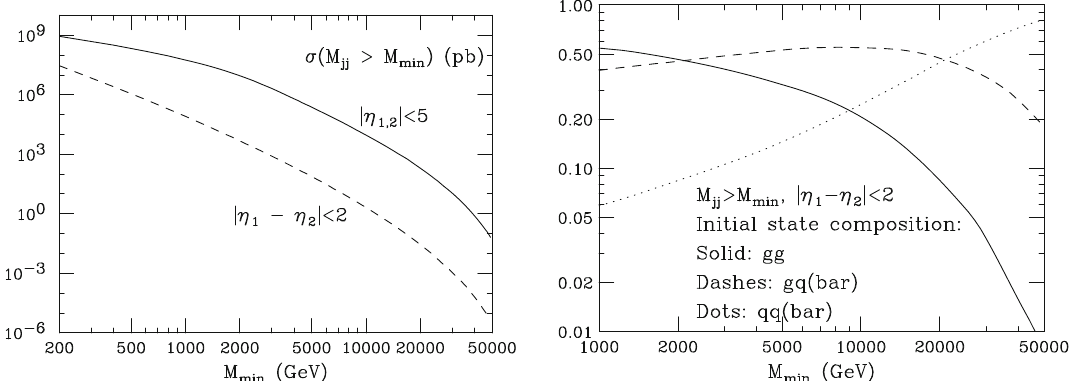
Fig. 5.9 High-mass dijet production rates (left) and initial-state composition